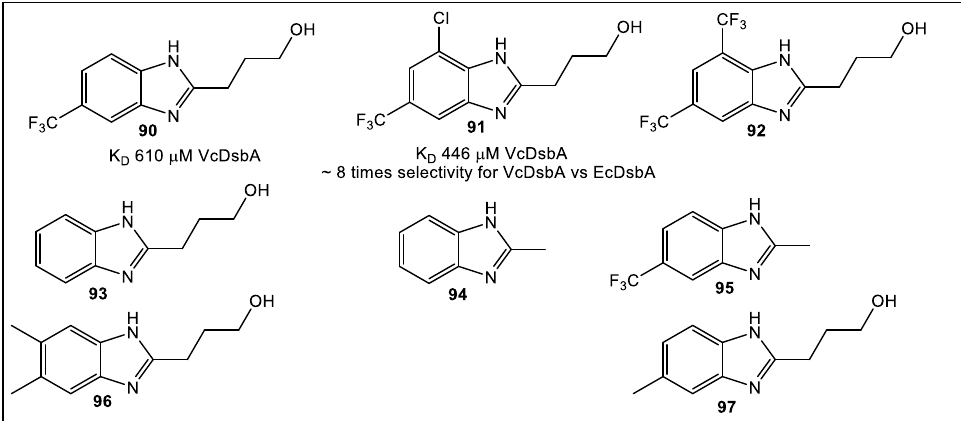
Figure 16. Structures of fragment 90 analogues screened by 1 H- 15 N HSQC NMR. To elucidate the differences in ligand binding of fragment 91 to VcDsbA vs. EcDsbA, crystal structures were obtained of each, complexed with sodium taurocholate, a known ligand. Crystallography showed that sodium taurocholate exhibits binding orientations in complex with VcDsbA that differ from that which occurs with EcDsbA. In addition, the protein–ligand interactions resulting in stabilization of binding orientations are revealed [76].